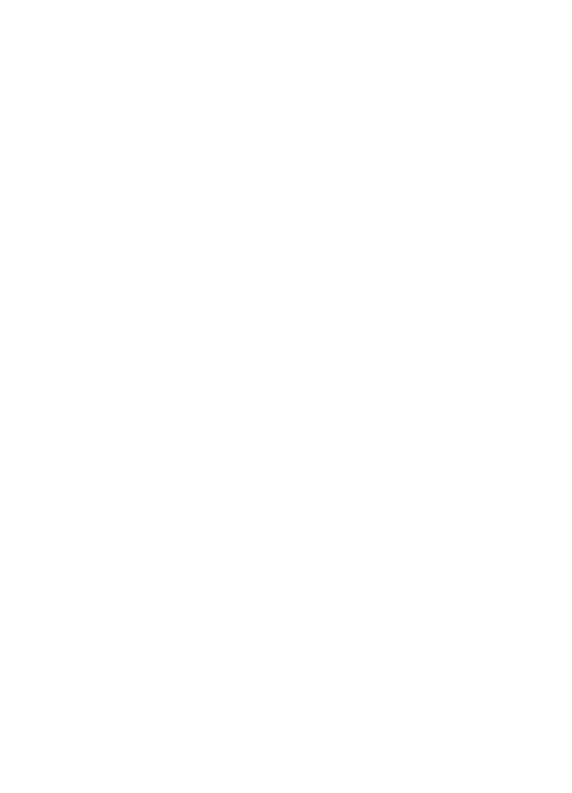
Figure 1. The mechanism of induction of hypogonadotropic hypogonadism by hyperprolactinemia. Prolactin acts through prolactin receptors on metastasis-suppressor kisspeptin-1 neurons, with downstream disruption of GnRH secretion, followed by decreased production of gonadotropins, hypogonadotropic hypogonadism and anovulation.